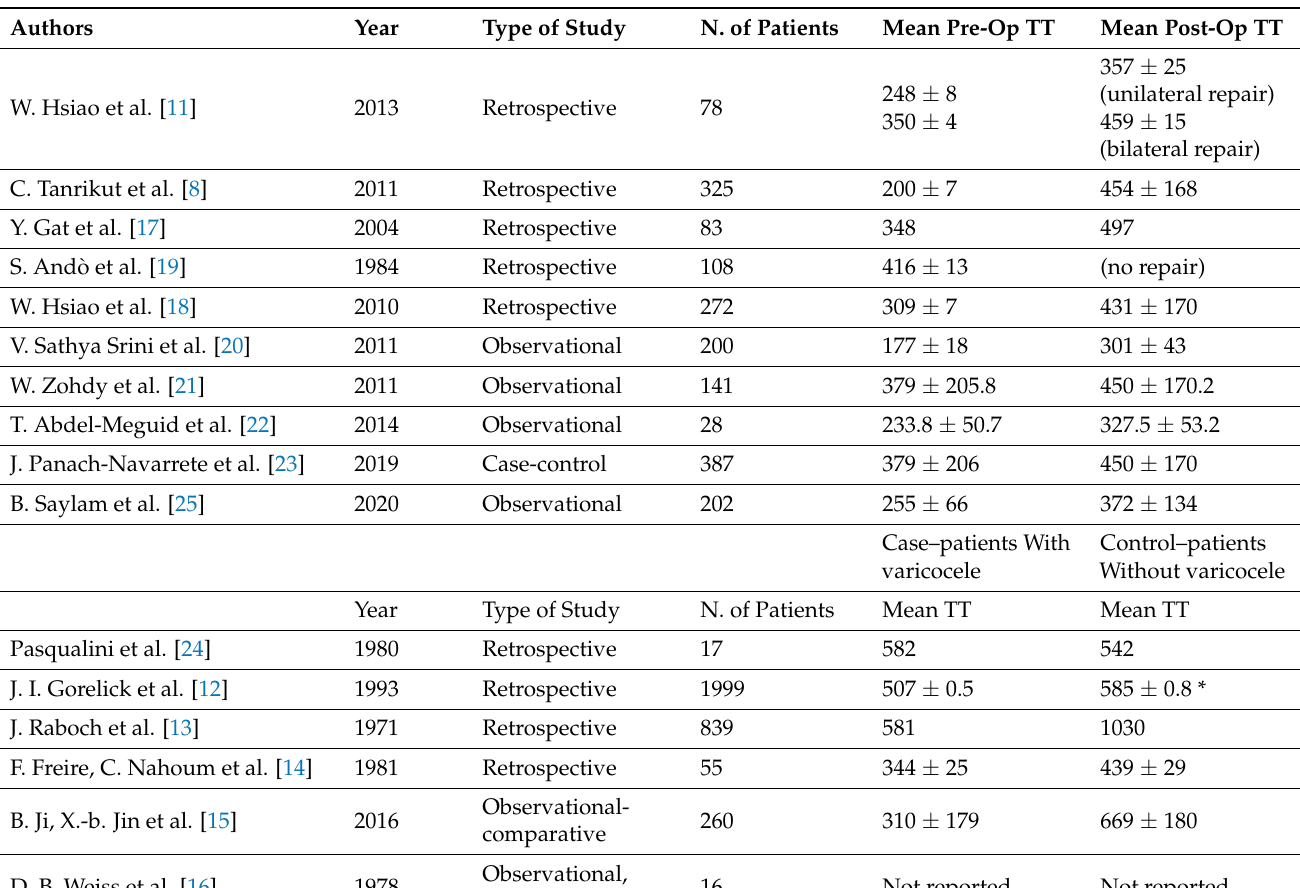
Table 1 lists the overall characteristics of the study included. Table 1. Characteristics of included